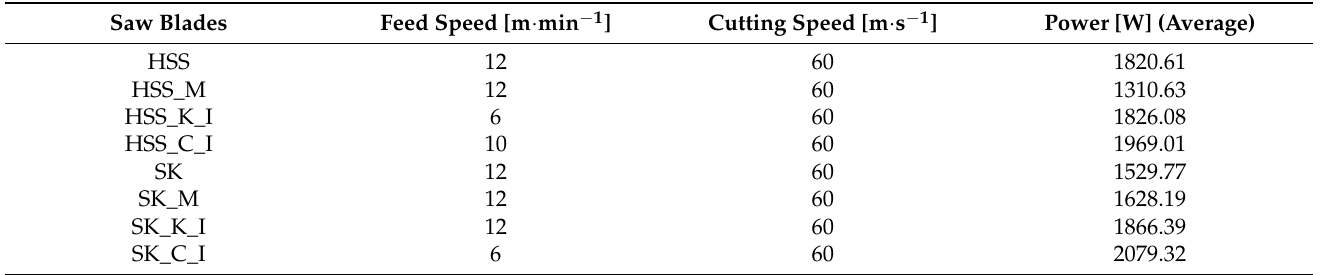
Table 4. Average performance values of saw blades (beech wood).